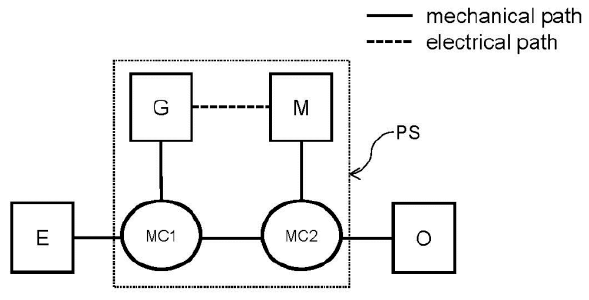
Figure 1. Schematic diagram of the power split electronic-continuously-variable-transmission (e-CVT) system.